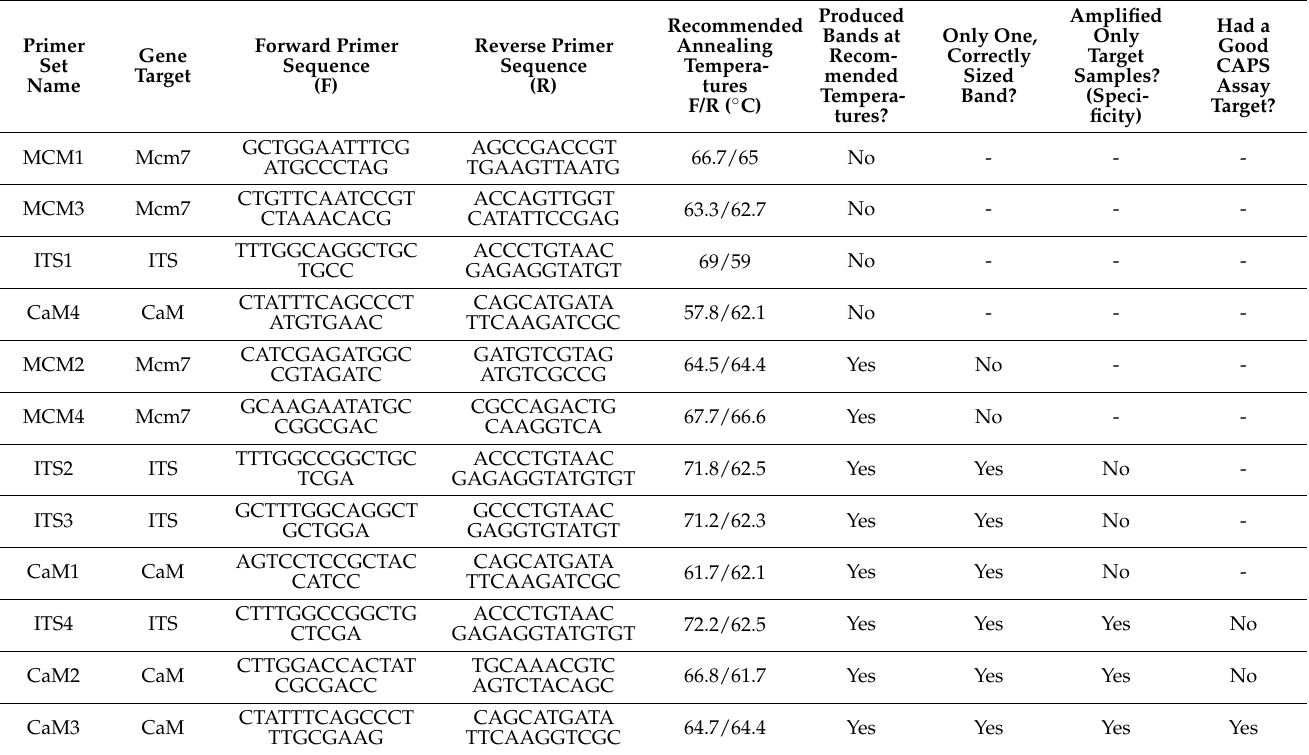
Table 2. All primers designed for this